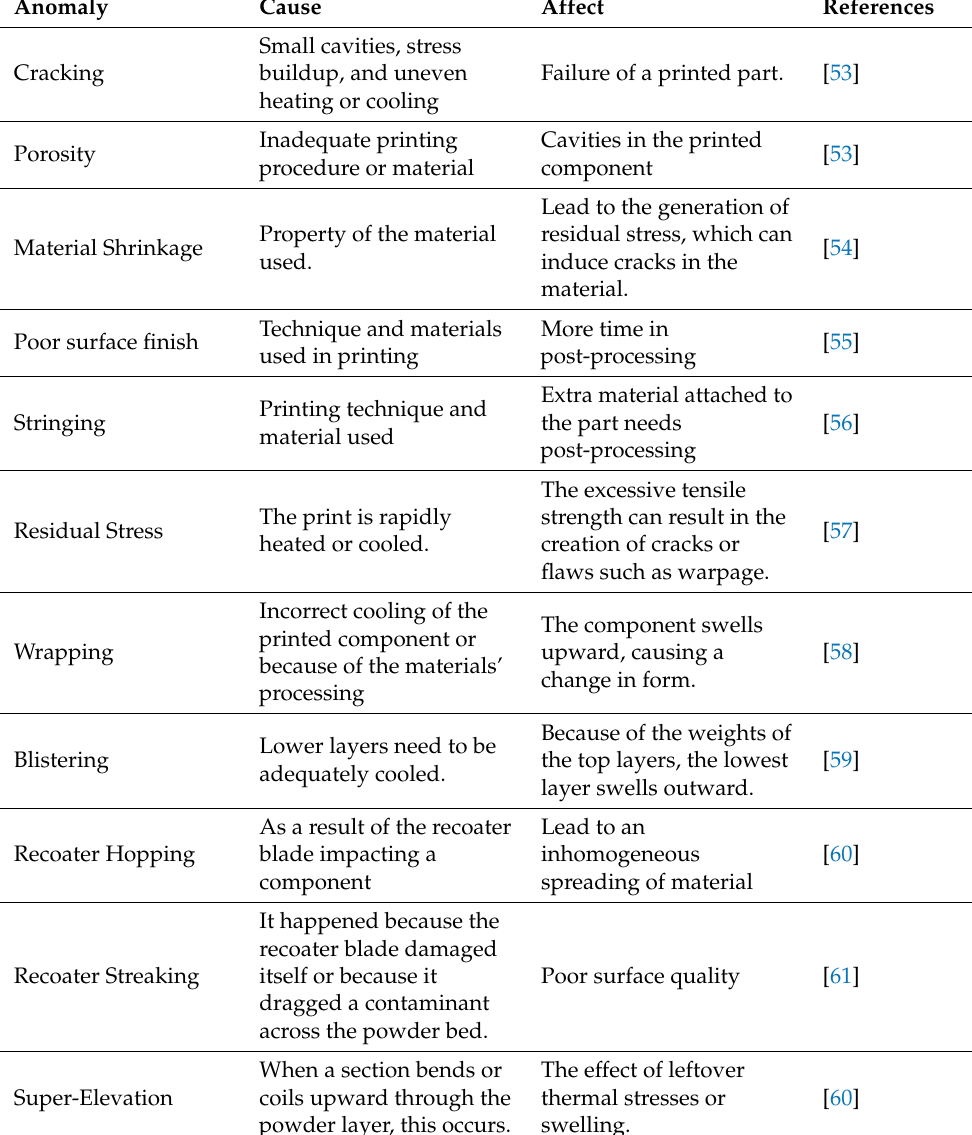
Table 3. Various defects associated with